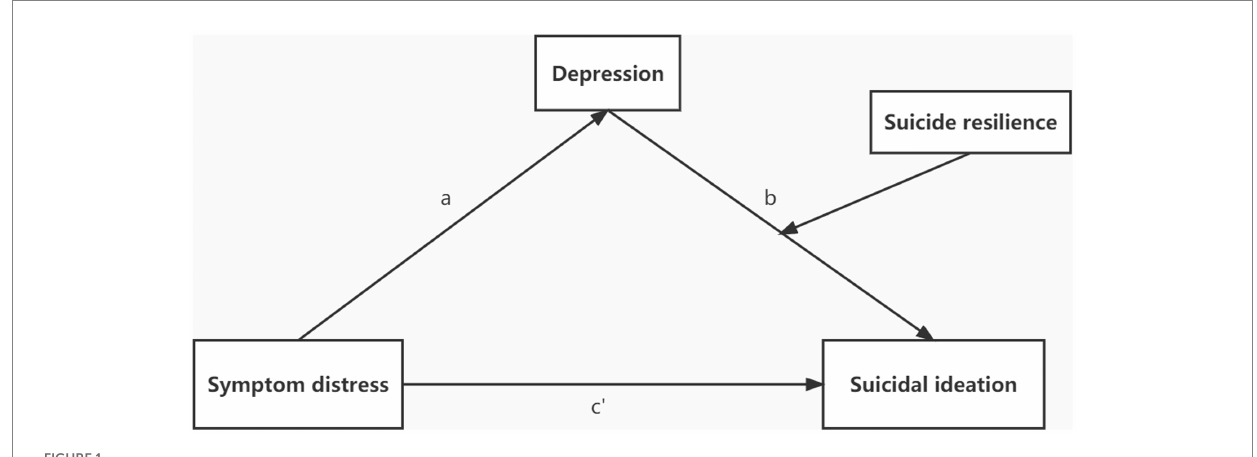
FIGURE 1 The hypothesized moderated mediation